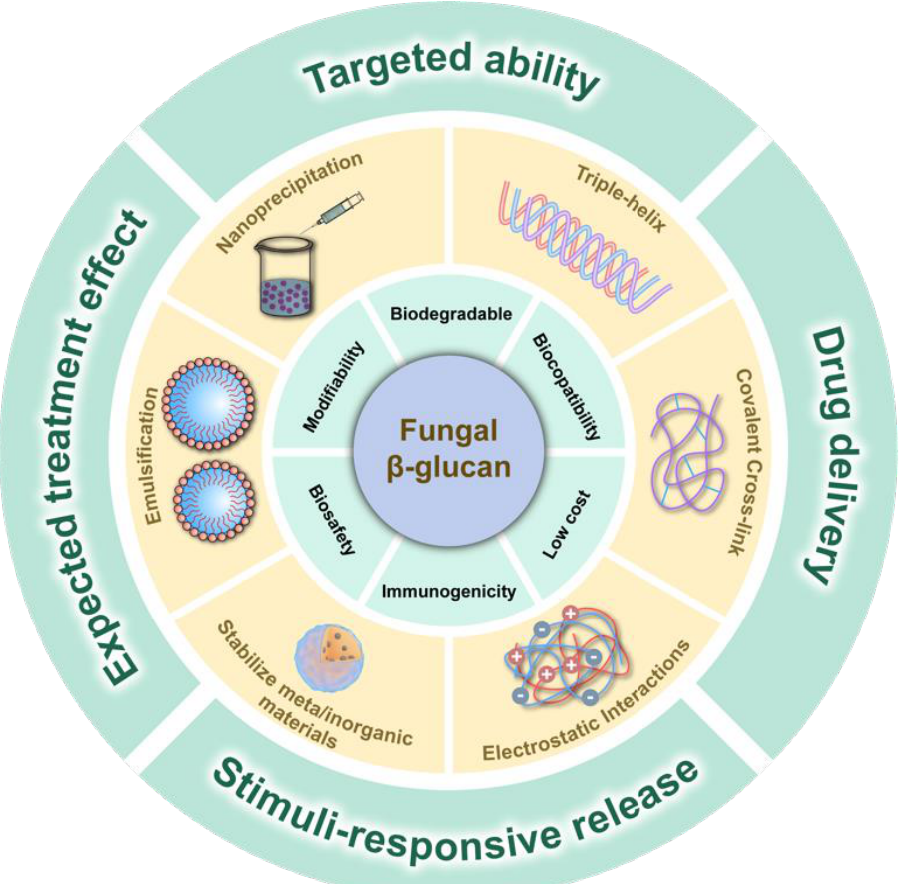
Figure 1. Schematic illustration of design and consideration of fungal β -glucan-based nanothera-